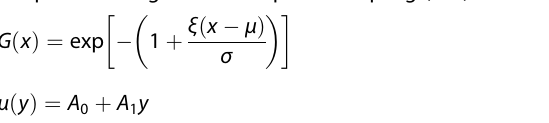
Fig. 10 Response of land-atmosphere interactions to SM pertur- bations. Time-mean spatial maps of difference between SM (1 st row), T max (2 nd row), SHF (3 rd row), LHF (4 th row), ET (5 th row) and SMM (6 th row) from the HIST-20 and HIST experiments (1 st column) as well as the HIST + 20 and HIST (2 nd column) experiments. Stippling in Figures indicate the regions where difference between the HIST-20/HIST + 20 and HIST experiments is signi fi cant at 95% con fi dence